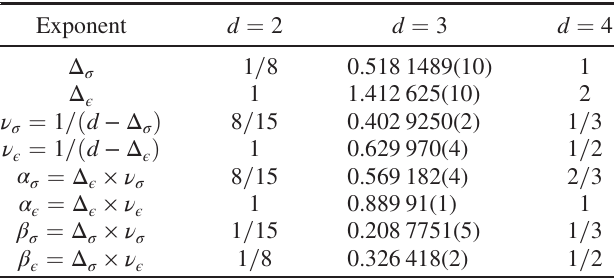
TABLE I. Upper two rows: Relevant scaling dimensions of the Ising CFT in d ¼ 2 , 3, 4 space-time dimensions; results for d ¼ 3 are from the most recent conformal bootstrap study [41]. The lower six rows denote the additional critical exponents probed in this work, which are derived from the scaling dimensions